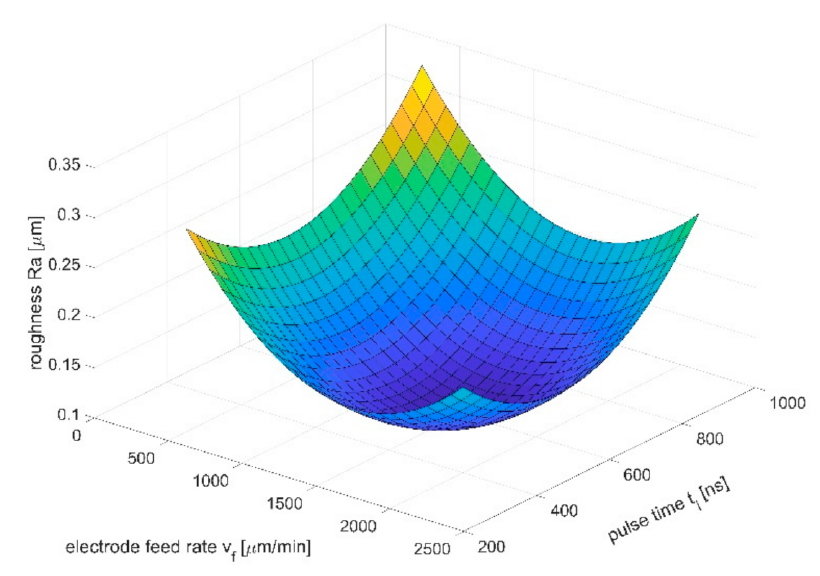
Figure 14. Dependence of the roughness parameter Ra on the length of the voltage pulse ti and the